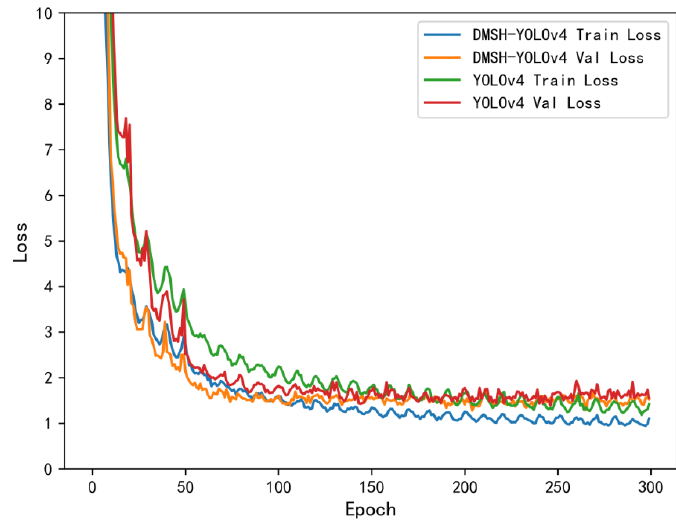
Figure 9. Loss curve during